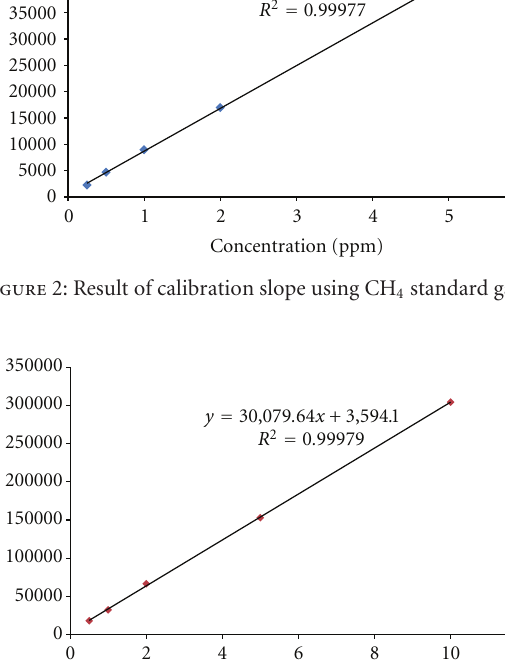
Table 5: Repeatability test of concentration analysis using N 2 O standard